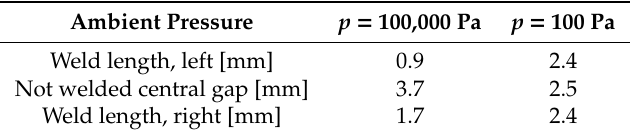
Figure 8. ( a ) Bright process glare at 100,000 Pa ambient pressure and ( b ) reduced process glare at 100 Pa ambient pressure in the joining gap at constant impact velocity v imp ≈ 243 m/s. Welding directions to the left and right from the central initial collision point. Table 5. Influence of the ambient pressure in the joining gap on the length of the weld seams at constant impact velocity v imp ≈ 243 m/s.